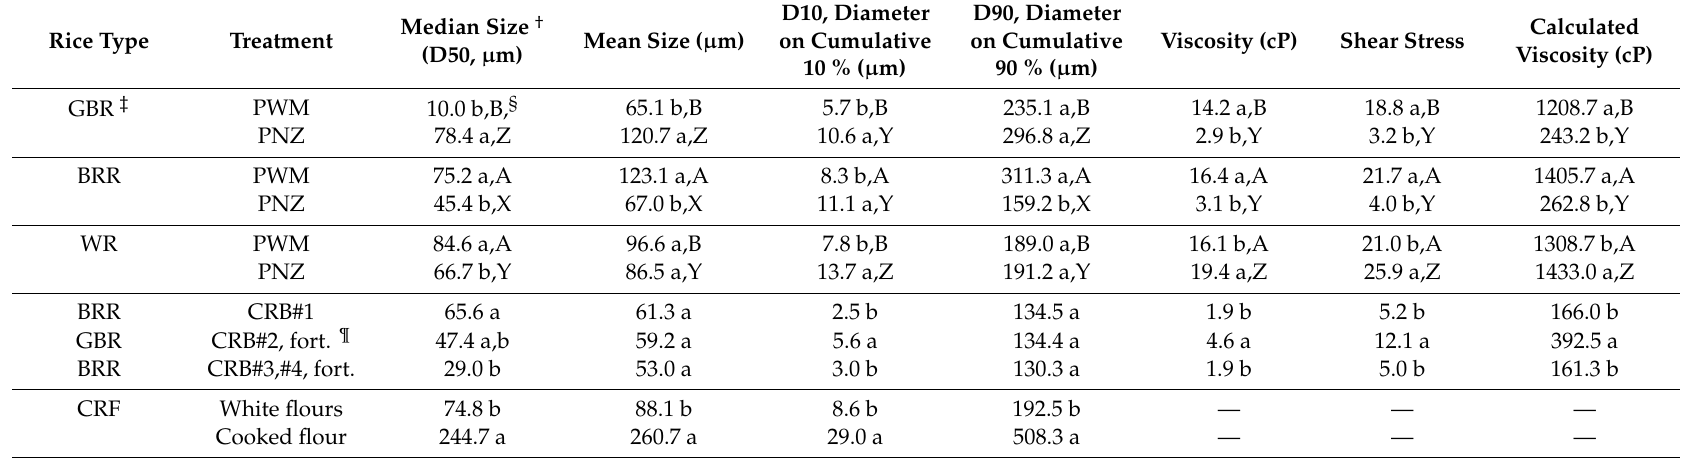
Table 2. Particle size distribution (Horiba) and viscometric (Brookfield) di ff erences in Rondo rice that was milled or dehulled, germinated, and then moved through a free-flowing green process, resulting in rice